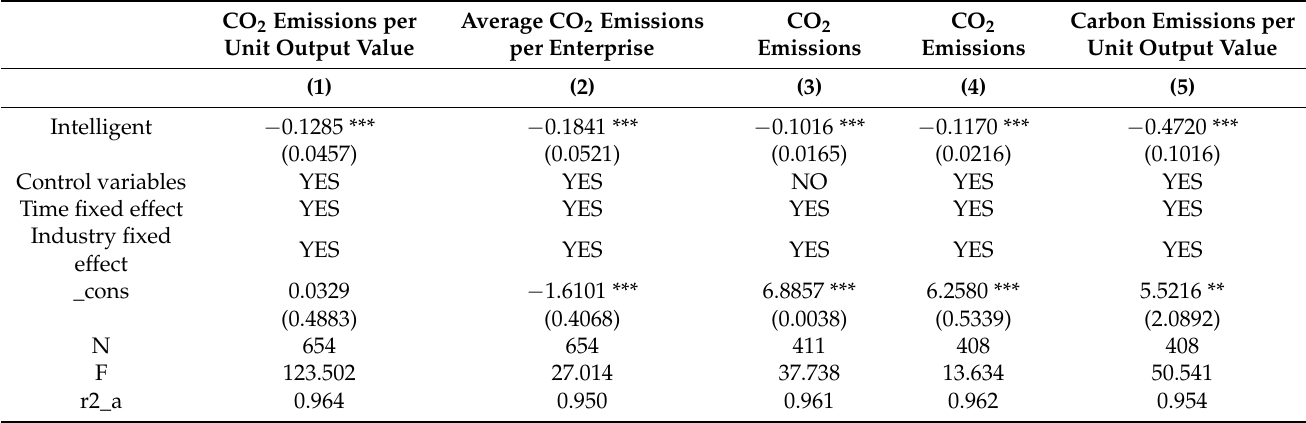
Table 6. Indicator replacement.